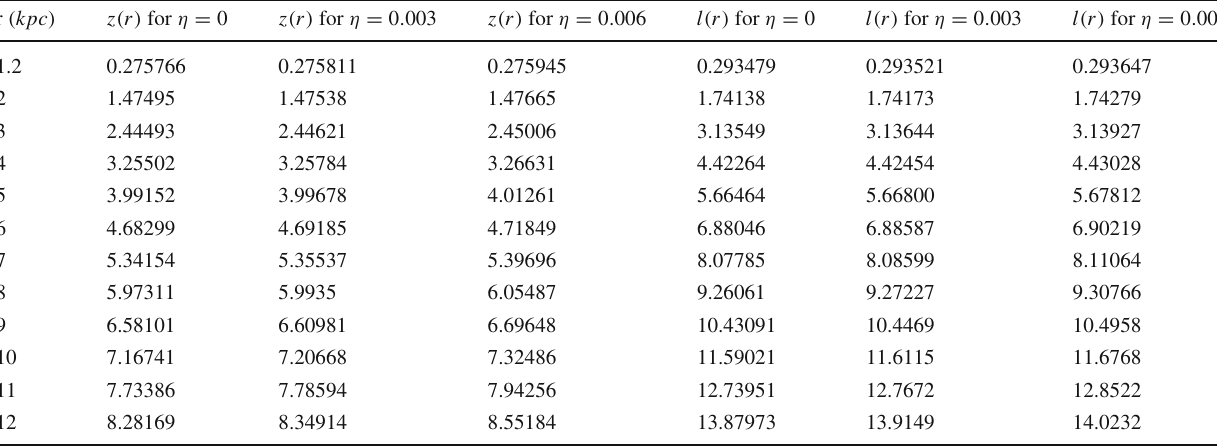
Table 1 Some specific numerical values of the embedding surface z ( r ) and proper radial distance l ( r ) corresponding to the parameters ρ 0